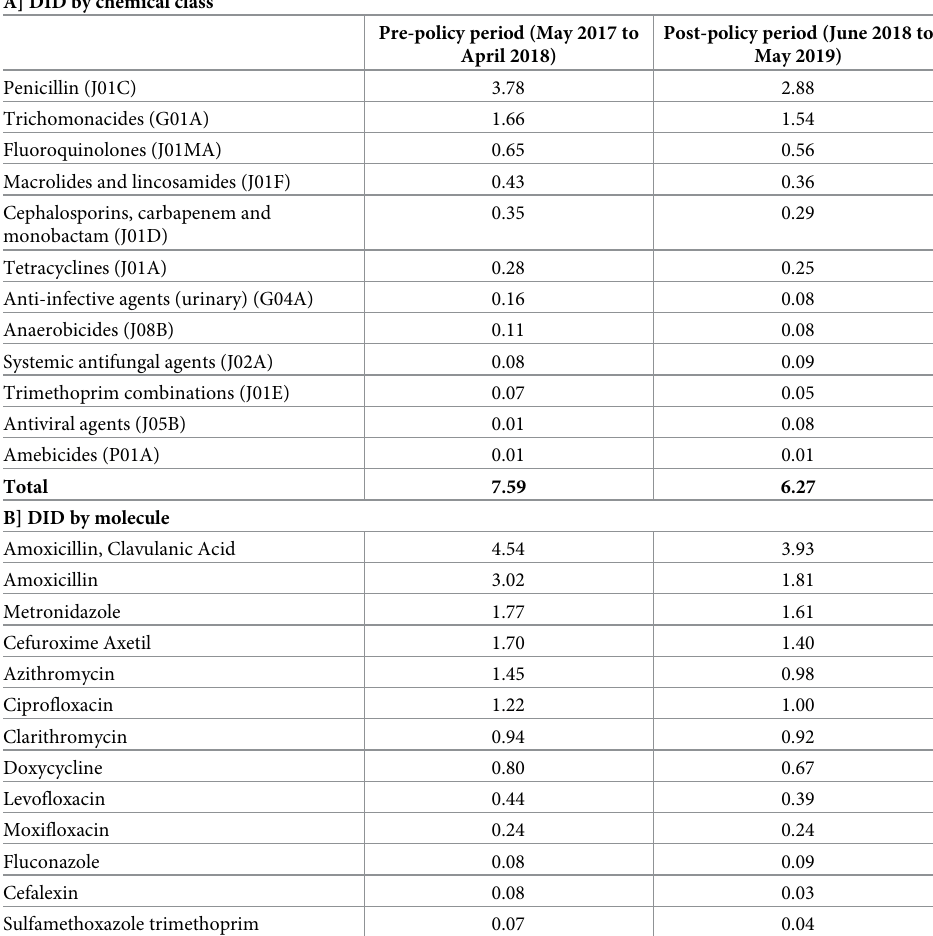
Table 1. Antimicrobial utilization (DID) by chemical class and molecule in the year pre- and post-policy enforce- ment in Saudi Arabia. A] DID by chemical